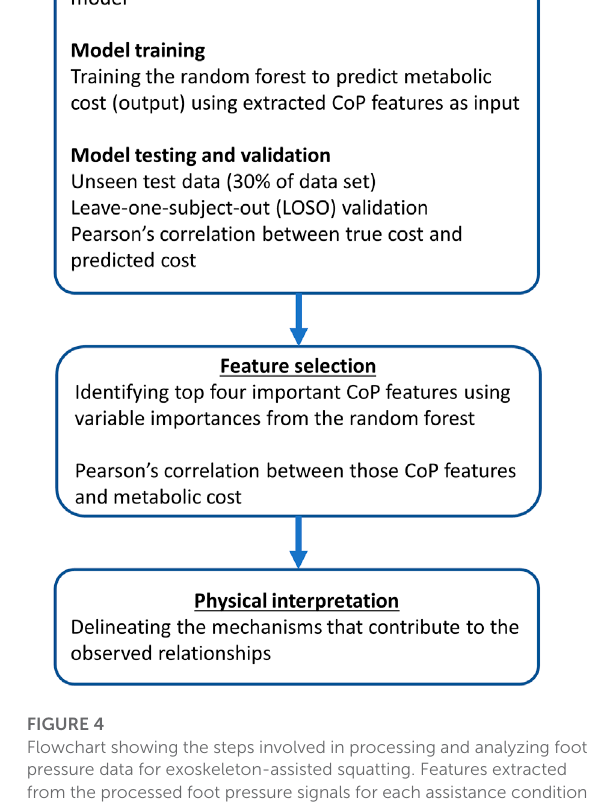
FIGURE 4 Flowchart showing the steps involved in processing and analyzing foot pressure data for exoskeleton-assisted squatting. Features extracted from the processed foot pressure signals for each assistance condition were used to train a machine learning model (random forest) to predict the corresponding metabolic cost. Feature selection was done to identify the CoP features that were most important in predicting the metabolic